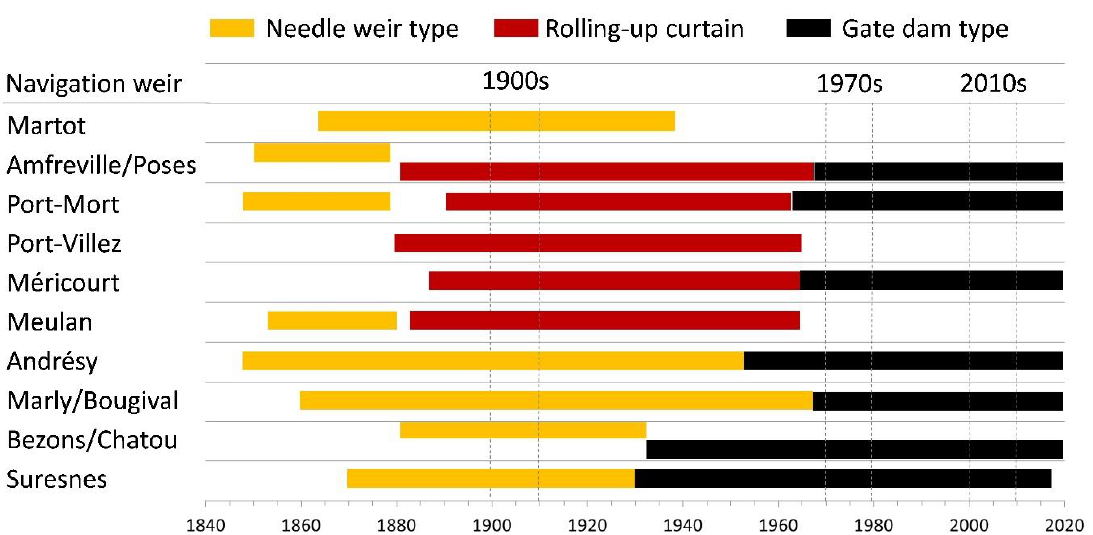
Figure 2. Technology and dates of weirs built on the Seine River from the sea to Paris. The weir at Marly was associated with hydraulic machinery first built in 1684 to raise the water up to an aqueduct tower supplying The Chateau of Versailles. When two names are indicated and bars are vertically staggered, the location of the navigation weir shifted.